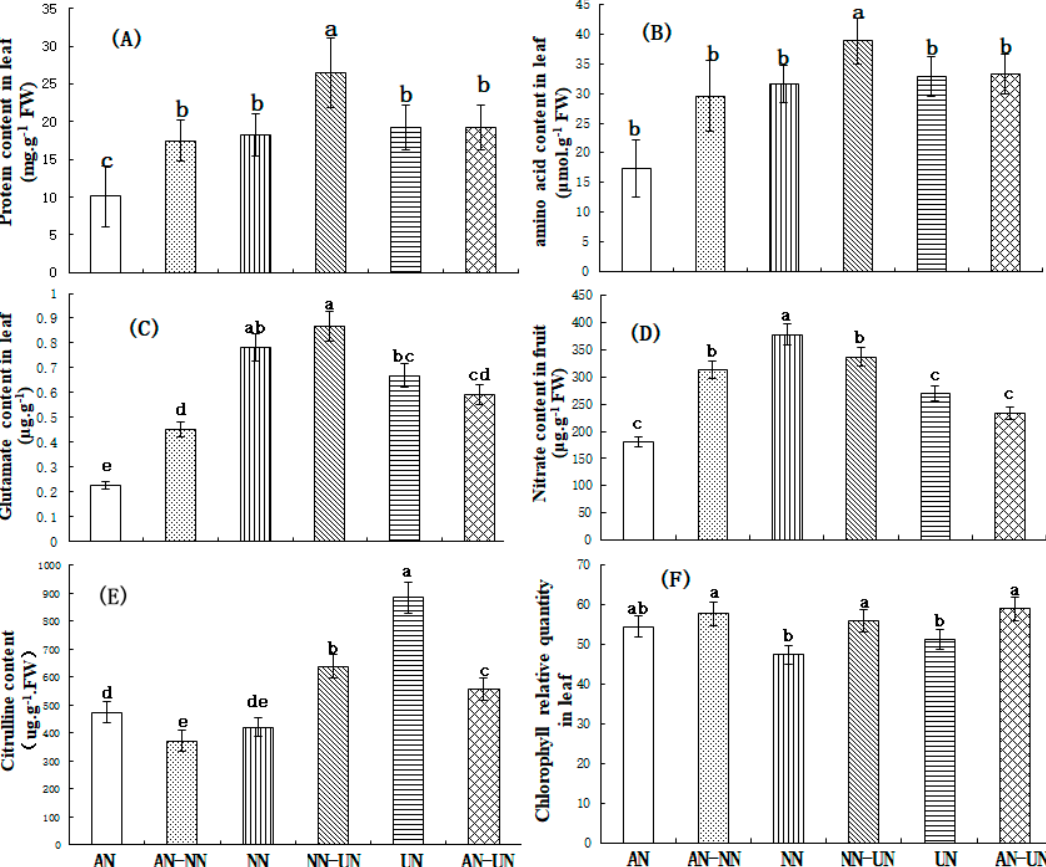
Figure 2. E ff ect of di ff erent nitrogen forms on the biochemical metabolites in cucumber. ( A ) protein Figure 2. Effect of different nitrogen forms on the biochemical metabolites in cucumber. A . protein content; ( B ) Amino acid content; ( C ) Glutamate content; ( D ) Nitrate content; ( E ) Citrulline content; content; B . Amino acid content; C . Glutamate content; D . Nitrate content; E . Citrulline content; F . ( F ) chlorophyll relative content. Bars represent the standard error. Di ff erent letters above the bars chlorophyll relative content. Bars represent the standard error. Different letters above the bars indicate significant di ff erences at p < 0.05 according to Tukey’s multiple comparison indicate significant differences at p < 0.05 according to Tukey’s multiple comparison test.